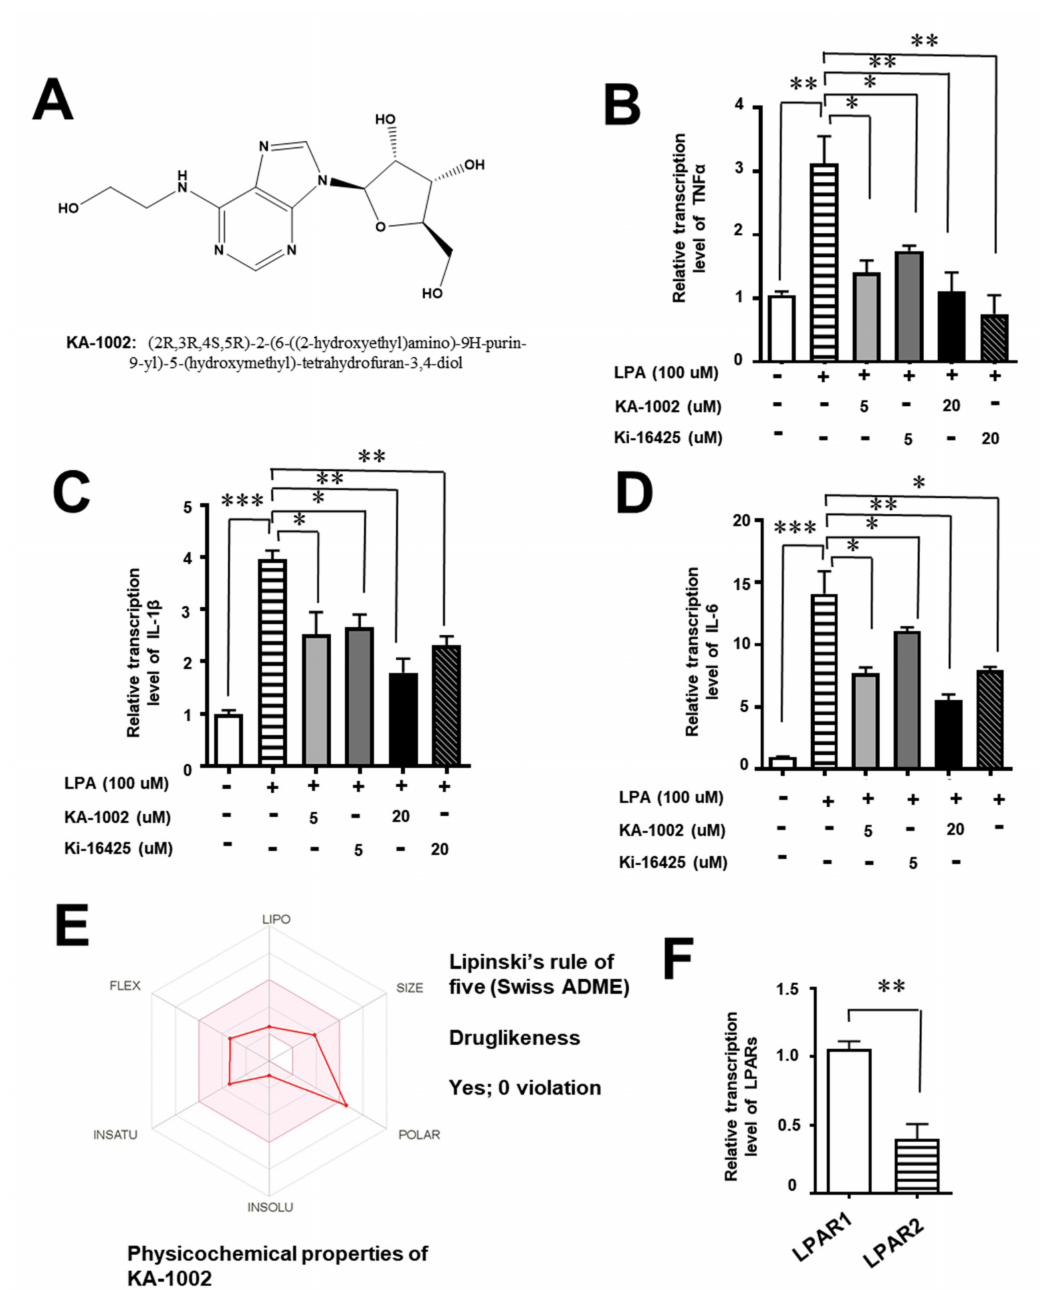
Figure 1. ( A ) Chemical structure of KA-1002, an inhibitor screened from cellular analysis based on lysophosphatidic acid (LPA) induced inflammatory cytokine, TNF α production using bovine blood vessel cell line, CAPE. Inhibitory e ff ects of KA-1002 on the production of LPA-induced ( B ) TNF α , ( C ) IL-1 β , and ( D ) IL-6 production in bovine endothelial cells, CAPE. The cells were exposed to KA-1002 and Ki-16425 at 5 and 20 µ M in the presence of 100 µ M of LPA for 18 h. Inhibition rates were calculated by comparing the corresponding levels of TNF α from the control (LPA-untreated) group under the high-throughput (HTS) system. Pooled results are shown from 3 independent experiments. ns: not significant; * p < 0.05, or ** p < 0.01, indicate significant di ff erences in comparison to the LPA-treated group according to two-tailed unpaired Student’s t-testing. Error bars denote standard error (SEM). ( E ) Physiochemical properties of KA-1002 based on Swiss ADME analysis. ( F ) Relative transcriptional level of LPAR1 and LPAR2 on CAPE cells. Pooled results are shown from 3 independent experiments. ** p <